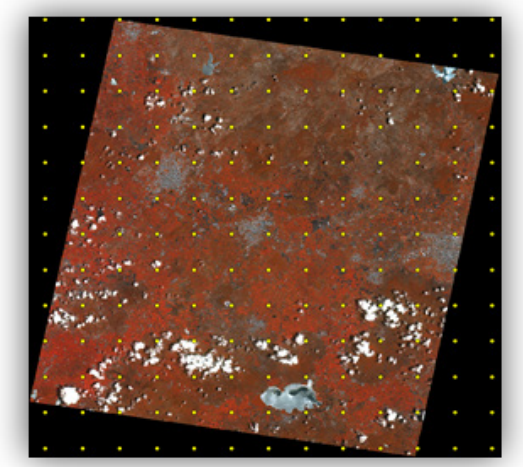
Figure 5. Mesh of resulting points for a